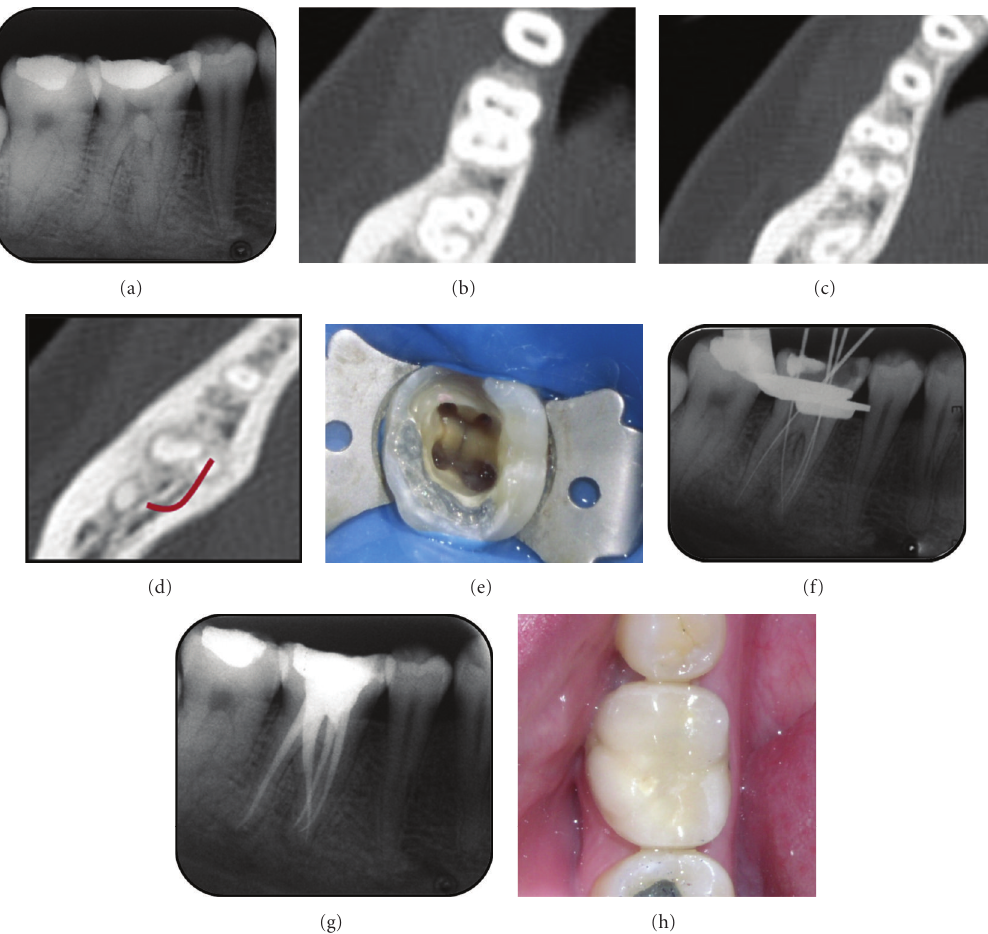
Figure 1: (a) Diagnostic radiograph, (b–d) computed tomographic scan in coronal, middle, and apical segments, respectively, (e) access cavity preparation, (f) working length determination, (g) post obturation, and (h) full coverage